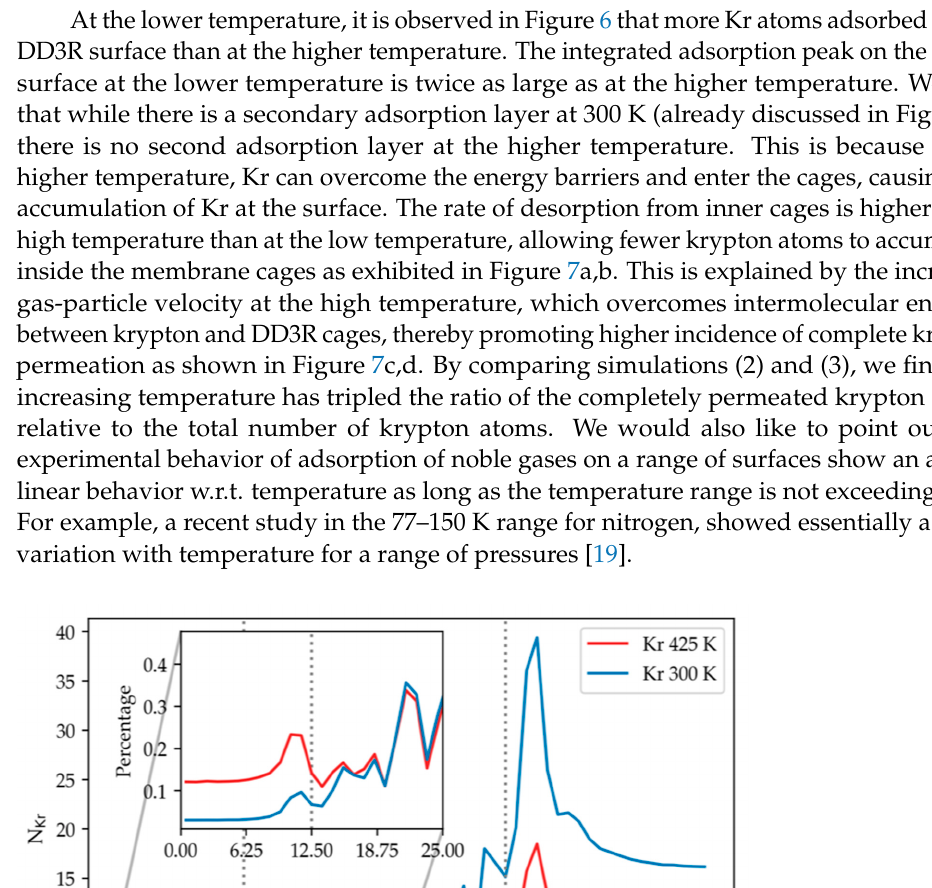
( d ) Figure 7. Molecular visualization of the temperature effect: ( a ) (inner cages) 300 K and 150 atm; ( b ) (inner cages) 425 K and 150 atm; ( c ) (overall view) 300 K and 150 atm; ( d ) (overall view) 425 K and 150 atm.